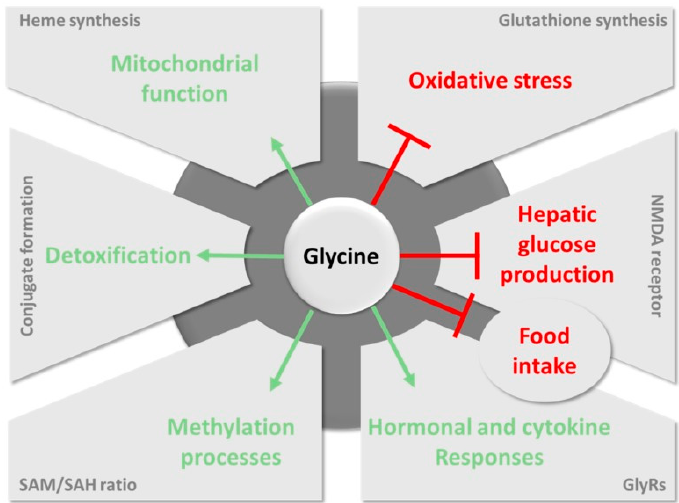
Figure 1. Main pathways involving glycine in health benefits. Favorable pathways induced by glycine and harmful pathways inhibited by glycine are represented in green and red, respectively. NMDA: N -methyl- d -aspartate; GlyRs: glycine receptors; SAM: S-adenosylmethionine; SAH: S-adenosylhomocysteine. Reproduced from ref. [15].